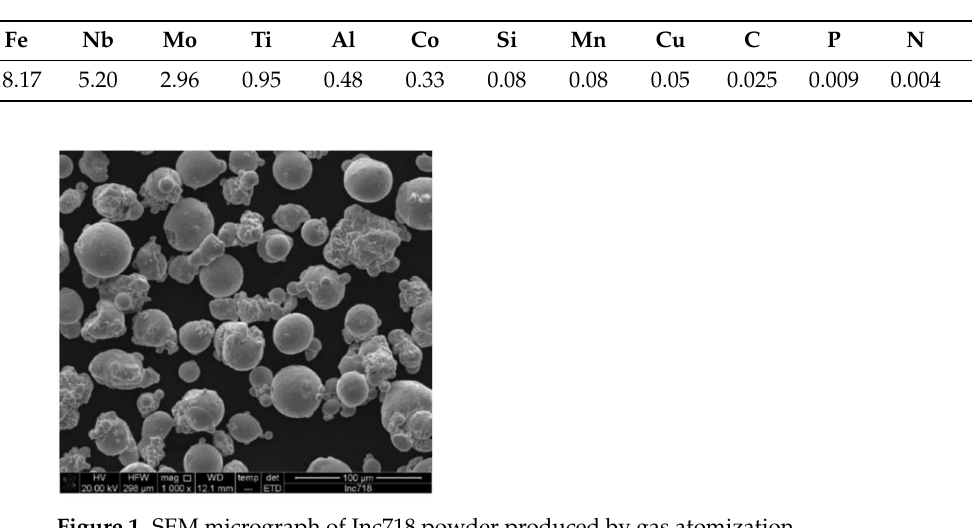
Table 1. Chemical compositions of Inc718 powder.